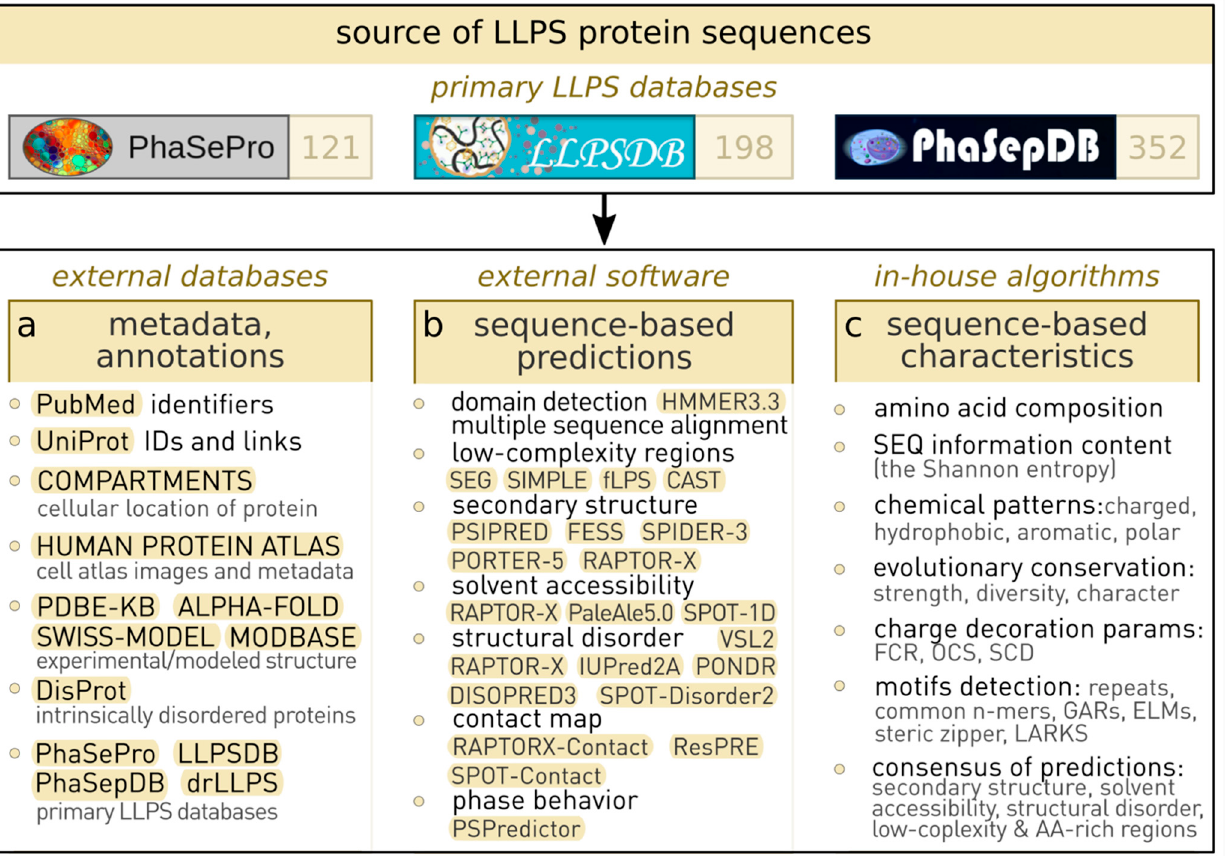
Figure 2. The BIAPSS repository collects the largest dataset of known LLPS proteins that have been identified from carefully curated primary LLPS databases. The computational framework starts from protein sequences downloaded from the UniProt database. The approach builds on three complementary components: ( a ) integration of metadata, annotation, and cross-links from the external databases; ( b ) comprehensive sequence-based bioinformatic analysis of evolutionary and biomolecular properties using state-of-the-art third-party software; and ( c ) meticulous physi- cochemical and compositional analysis and robust data integration using the in-house algorithms. The BIAPSS interactive web applications enable exploration through the distilled essence of the crafted characteristics.